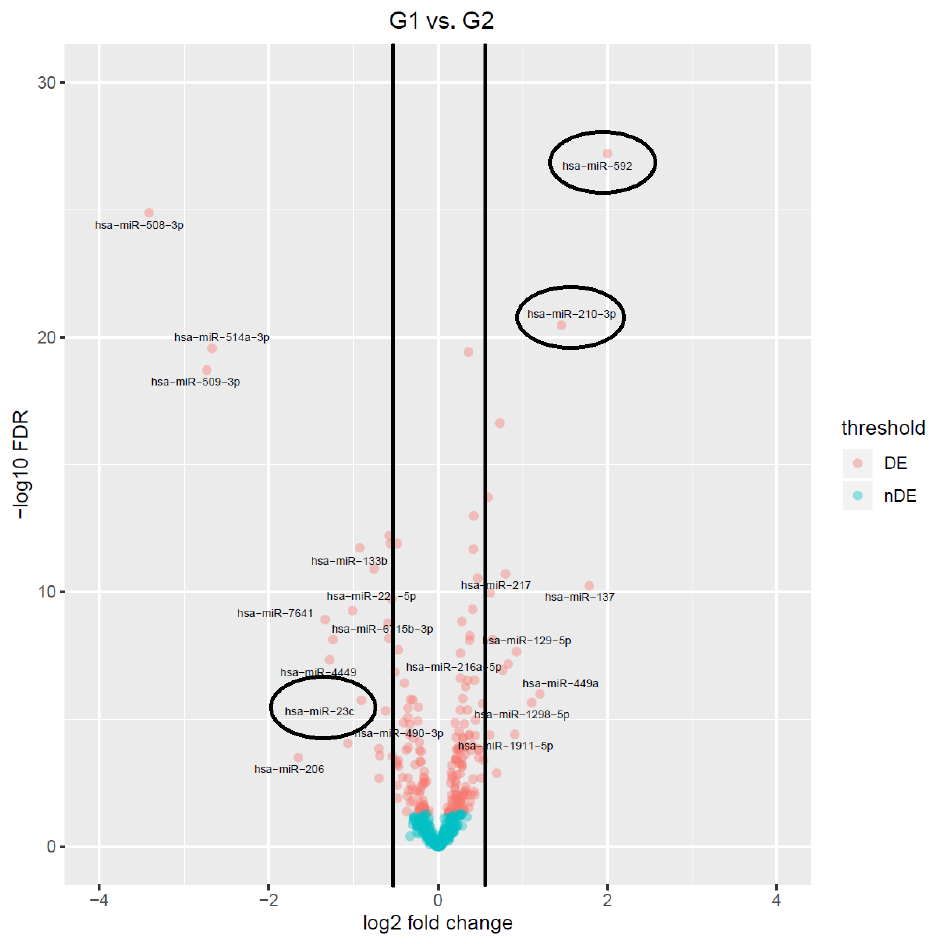
Figure 3. Volcano Plot comparing tumoral samples with Gleason score ≤ 7 (G1) with tumoral samples with Gleason score >7 (G2) in TCGA.